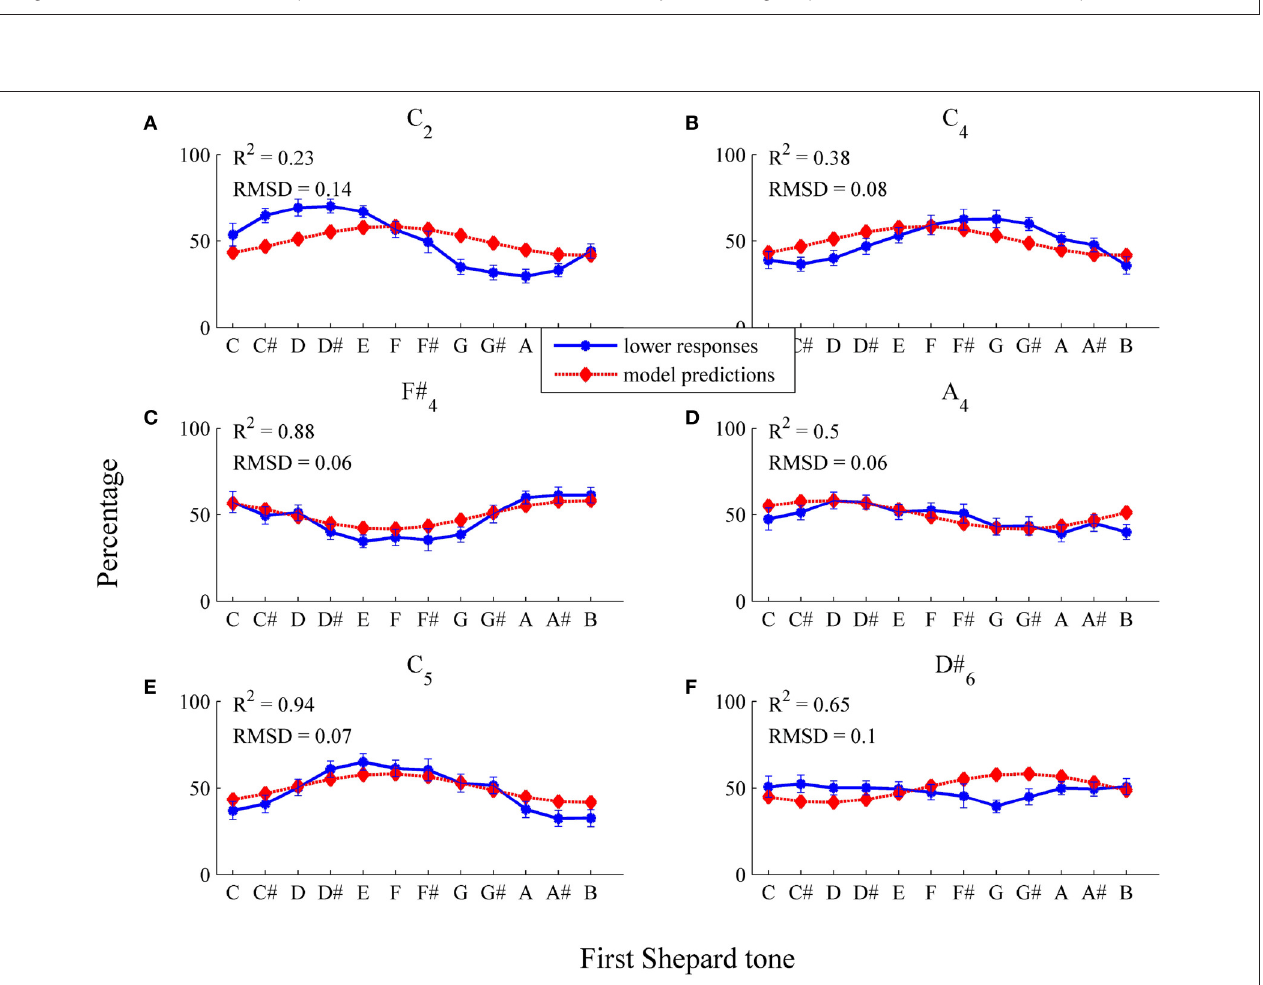
FIGURE 7 | (A) Distribution of individual highest pitch classes and the magnitude of pitch class effect ( n shifted from the envelope center (in semitones, st) and the magnitude of envelope effects ( n magnitude of effect. The vertical line represents the median of the clockwise distance by which the highest pitch class is shifted from the envelope center.